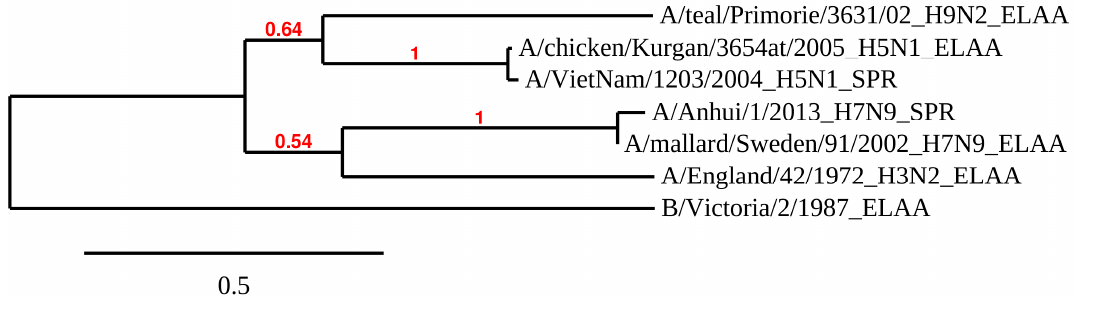
Figure 6. The phylogenetic tree of HA1 subunits of HAs used for the affinity studies of aptamer RHA038 and its derivatives. It was obtained with Phylogeny.fr software [40] from the amino acid sequences of the HA1 subunits of six influenza A and one influenza B viral strains. The scale bar indicates the numbers of amino acid substitutions per site. The bootstrap value is indicated for each inner branch of tree. The method of affinity analysis used for the specific HA was indicated after the full name of the corresponding viral strain.